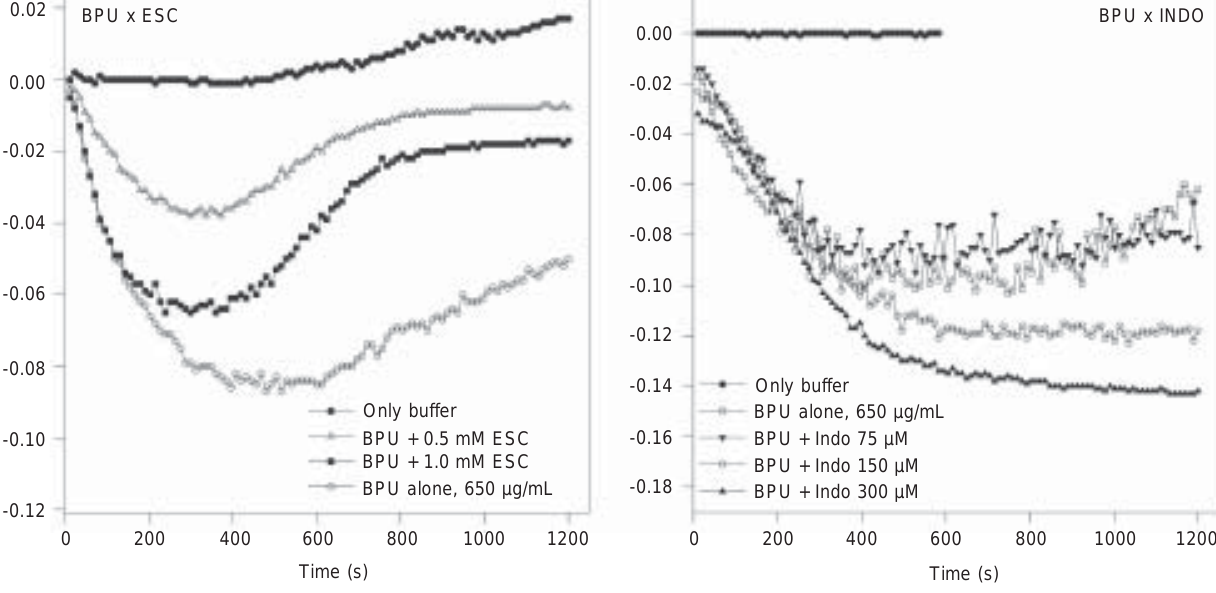
Figure 3. Effect of inhibitors of arachidonate metabolism on platelet aggregation induced by Bacillus pasteurii urease. Rabbit platelet-rich plasma suspensions were pretreated for 2 min with the indicated final concentrations of esculetin (ESC, left panel) and indomethacin (INDO, right panel) and then exposed to 0.7 mg/mL B. pasteurii urease (BPU; Sigma). The decrease in absorbance readings at 650 nm indicating platelet aggregation was monitored every 11 s for 20 min with a plate reader (13). Typical experiments are shown.